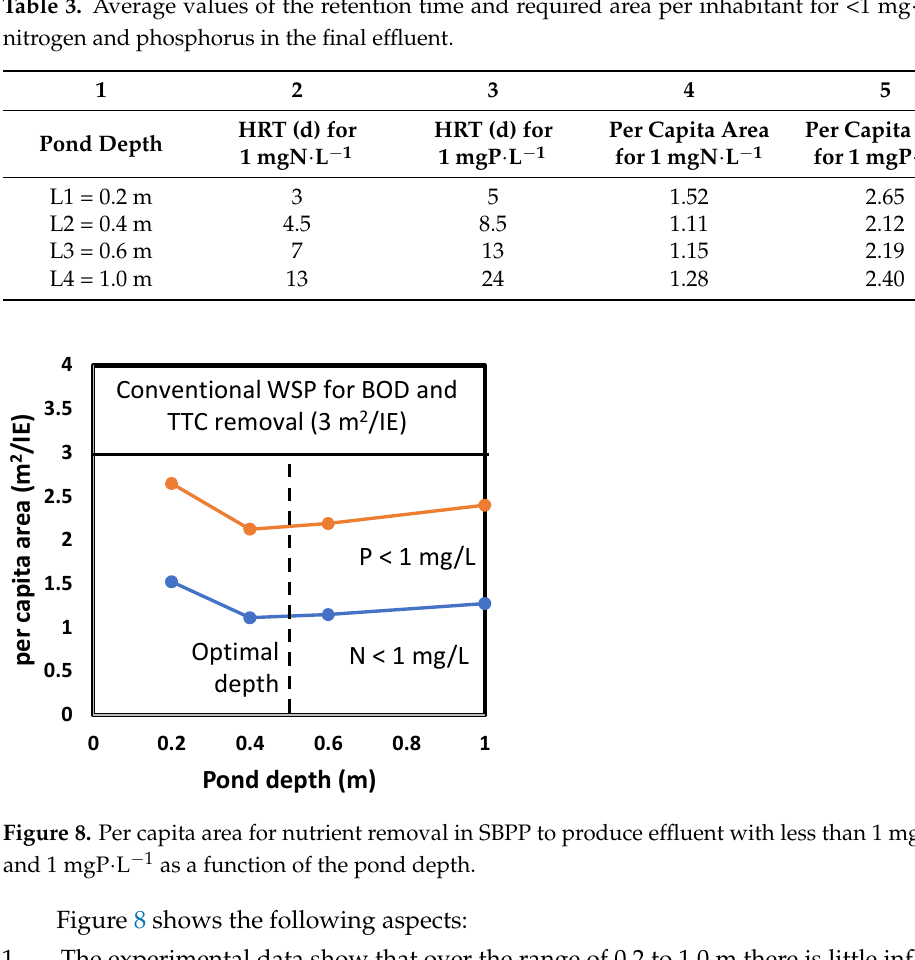
15 of 18 Figure 7. Logarithm of residual phosphorus concentration in sequential batch polishing ponds as a function of the pH. 3.4. Per Capita Area Having determined the relevant constants to simulate nitrogen and phosphorus re- moval in the SBPP, the next step is to optimize the SBPP design. The variable of greatest interest for the design optimization is not the retention time, but the area per capita. This variable is related to depth. The area required for the construction of polishing ponds can be calculated by considering that the retention time is the ratio between the volume of the pond and the applied daily flow, so that the area per capita can be expressed as: A ie = (HRT × Q ie ) ⁄ H (30) where: A ie = area required for SBPP (m 2 per inhabitant equivalent); HRT = hydraulic re- tention time (days); Q ie = daily contribution por inhabitant flow (m 3 ·ie − 1 ·day − 1 ); H = pond depth in m. Using the data in Figure 3, Table 3 shows the observed HRT for a final effluent with a concentration with < 1 mgN · L − 1 and <1 mgP·L − 1 in ponds with different depths (Columns 2 and 3). Columns 4 and 5 show the values of the area per capita for the residual concen- trations of 1 mgN·L − 1 and 1 mgP · L − 1 , calculated with Equation (29) for a contribution per